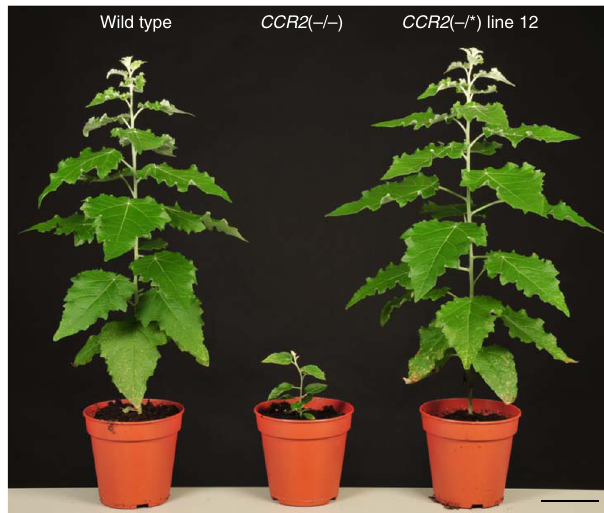
Fig. 1 Phenotype of poplar containing biallelic CCR2 mutations. Plants were grown for 11 weeks in the greenhouse. CCR2 ( − / − ) and CCR2 ( − /*) line 12 poplars ( P. tremula × P. alba) were generated via CRISPR/Cas9 using gRNA1 (targeting the third exon of both CCR2 alleles). The status of the CCR2 alleles present in P. tremula × P. alba is denoted between the parentheses; the fi rst one represents that of the P. tremula allele, the second one that of the P. alba allele; − , knockout; *, protein-modi fi ed. The plants shown are representative of twenty biologically independent samples for wild type and CCR2 ( − / − ). One plant was available for CCR2 ( − /*) line 12. Scale bar = 10